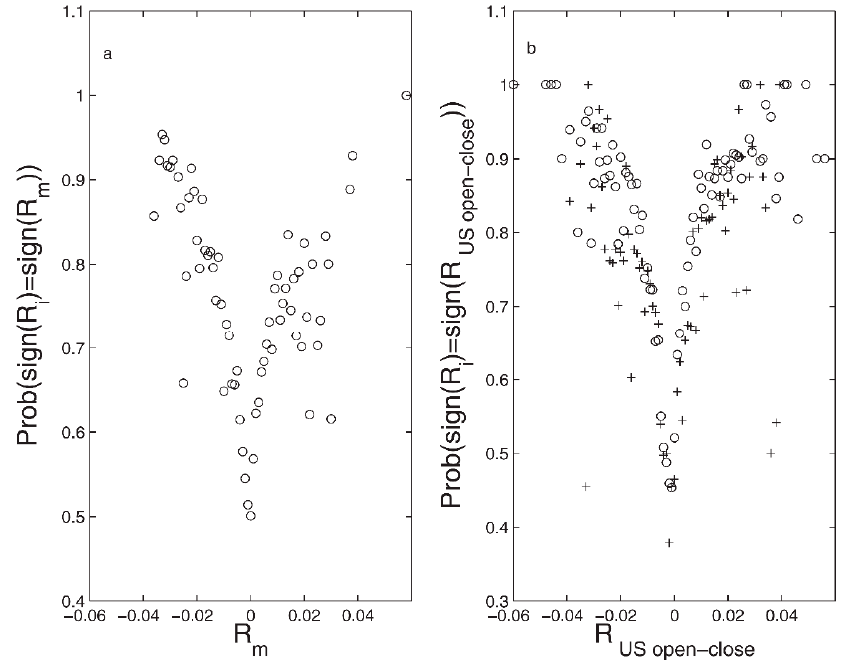
Figure 4. Illustration of change blindness: a large world market return ( a ) or US market return ( b ) impacts a given stock exchange, whereas small returns have random impact. ( a ) conditional probability that the daily return R i of a given country’s stock market index has the same sign as the world market return; ( b ) conditional probability that the close–open return R i of a given country’s stock market index following a U.S. open–close has the same sign as the U.S. open–close return (+: European markets; circles: Asian markets). The figures were created using almost nine years of daily returns from 24 of the major stock markets worldwide. For more information, see (Andersen and Sornette 2005; Liu et al. 2017).